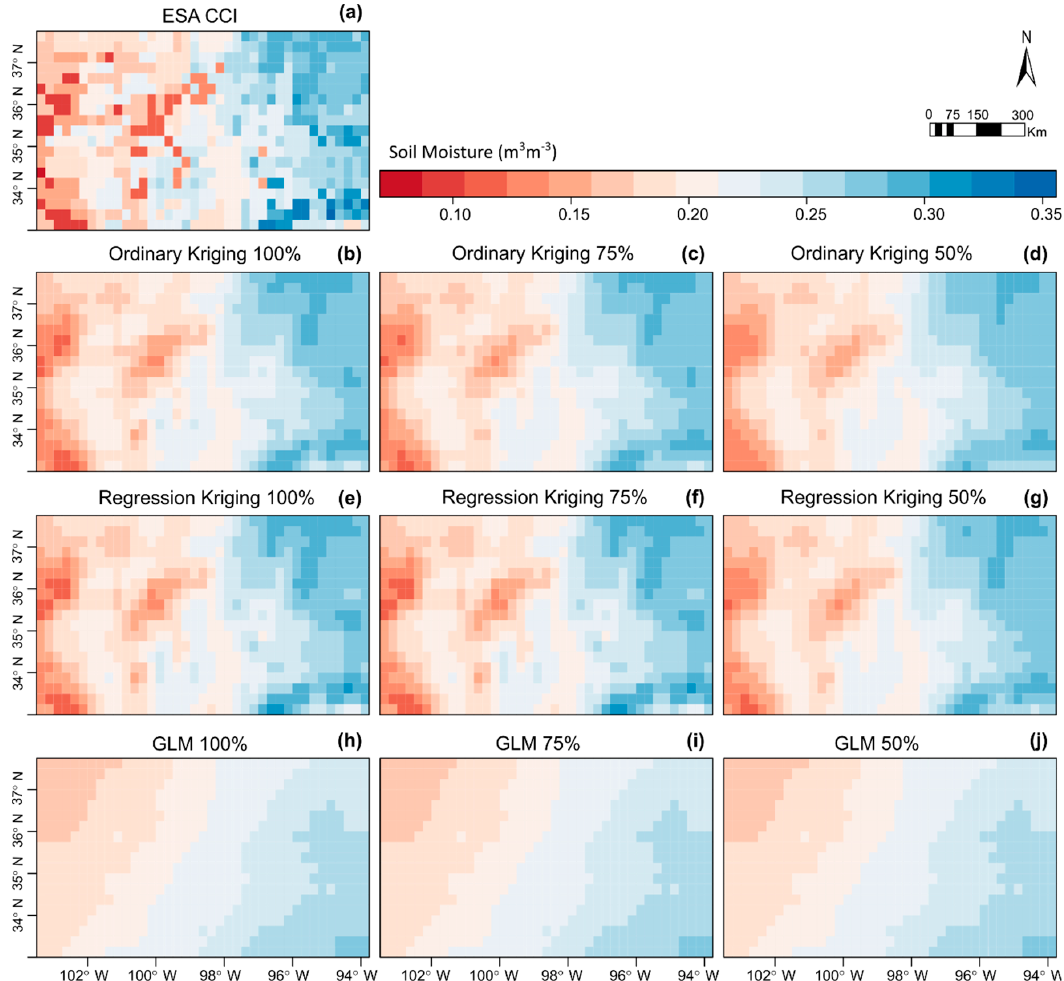
Figure 10 . Mean soil moisture values during the study period (January 2000–September 2012) over the region of interest. ( a ) Mean values of original ESA CCI soil moisture estimates; no gap-filling methods applied; ( b ) Soil moisture mean values modeled using OK and 100% of available valid data; ( c ) Soil moisture mean values modeled using OK and 75% of available valid data; ( d ) Soil moisture mean values modeled using OK and 50% of available valid data; ( e ) Soil moisture mean values modeled using RK and 100% of available valid data; ( f ) Soil moisture mean values modeled using RK and 75% of available valid data; ( g ) Soil moisture mean values modeled using RK and 50% of available valid data; ( h ) Soil moisture mean values modeled using GLM and 100% of available valid data; ( i ) Soil moisture mean values modeled using GLM and 75% of available valid data; ( j ) Soil moisture mean values modeled using GLM and 50% of available valid data.